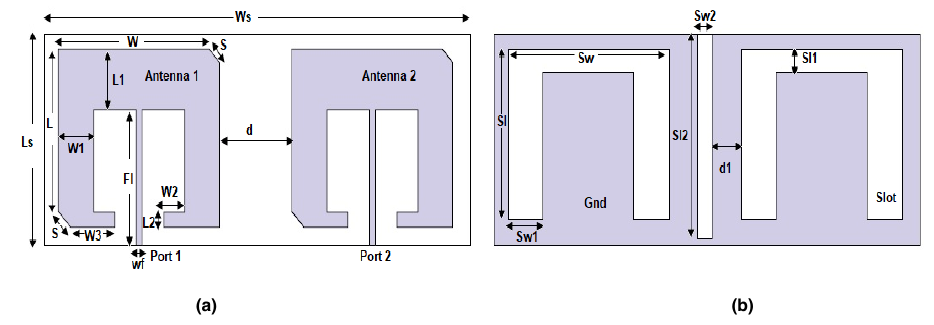
FIGURE 1. Proposed CP-MIMO Textile Antenna (a) Top View (b) Bottom View TABLE I . Proposed Antenna parameter dimensions in mm